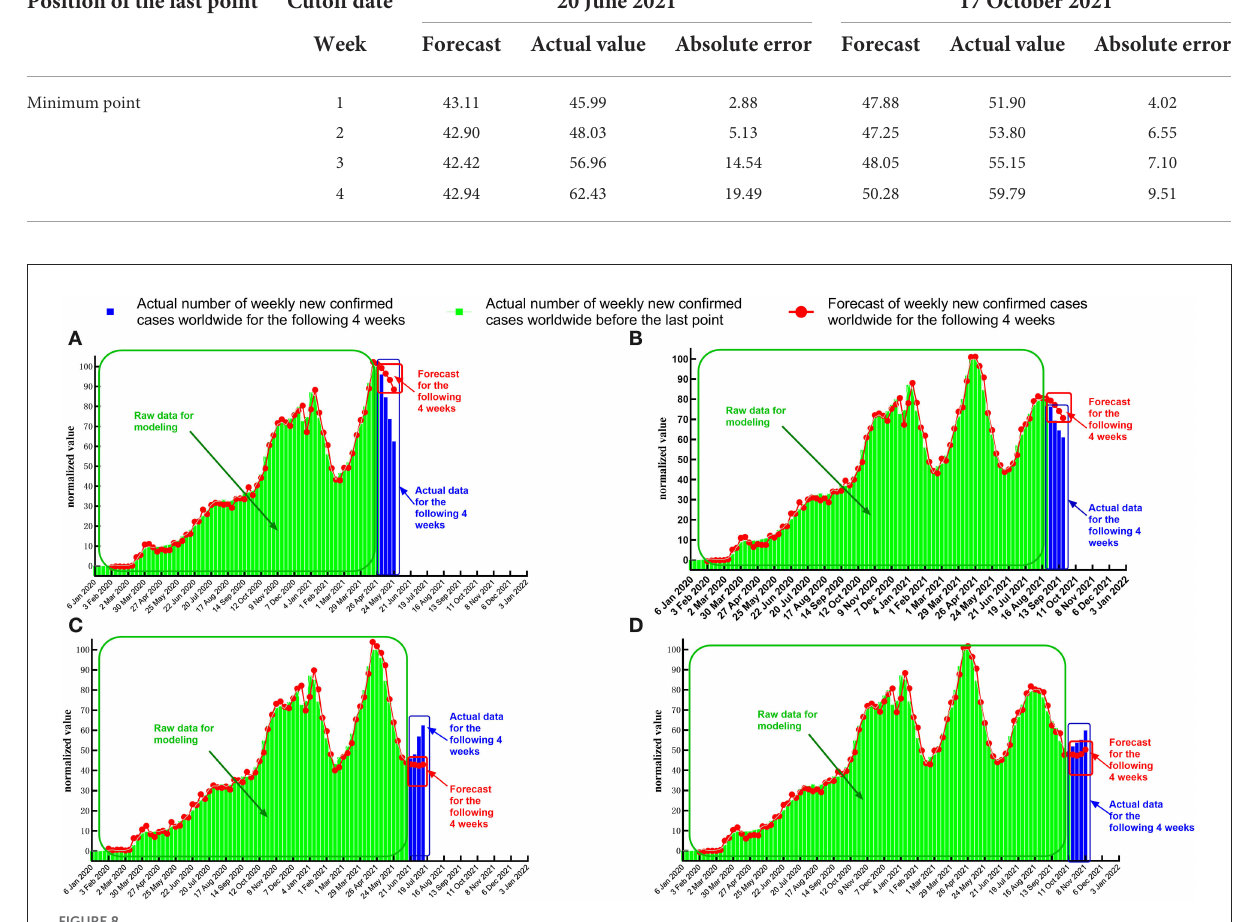
FIGURE8 Timing diagram of forecasts and actual values when the last point of the response sequence is at the maximum or minimum point. (A) Date of the last point: 2 May 2021 (maximum 1). (B) Date of the last point: 29 August 2021 (maximum 2). (C) Date of the last point: 20 June 2021 (minimum 1). (D) Date of the last point: 17 October 2021 (minimum